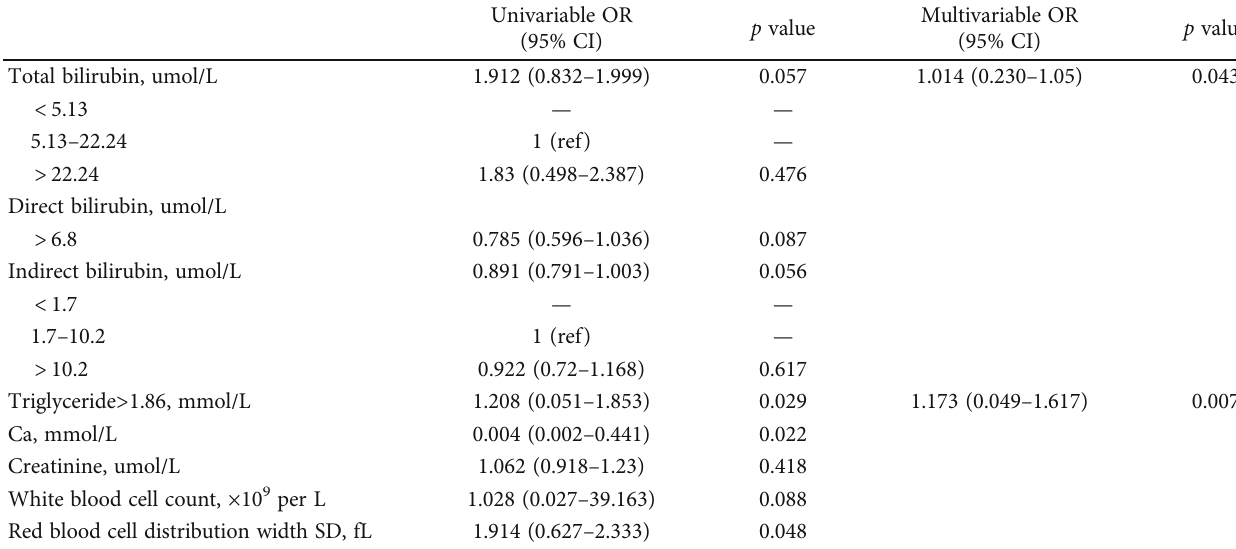
Table 5: Risk factors associated with elderly COVID-19 patients with hypertension.